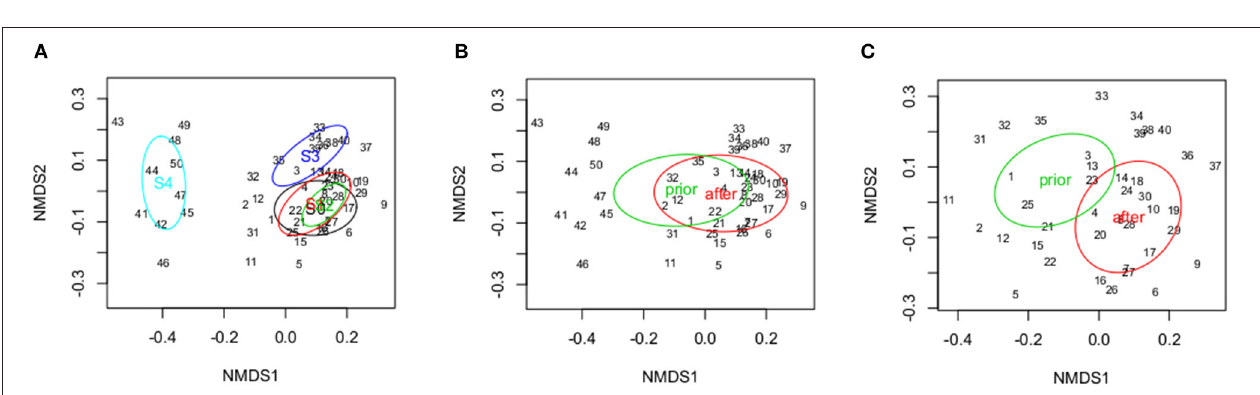
FIGURE 6 | Number of sensitive taxa in spring and autumn prior to (2012 and 2013, dark colors) and after (2014, 2015, and 2016; light colors) the wastewater treatment plant (WWTP) upgrade. Data are shown as arithmetic means and standard deviations. Data for the sampling sites at the Schussen river are shown in red colors: S 0 upstream of the WWTP and upstream of the stormwater overflow basin (SOB) Mariatal, S 1 upstream of the WWTP and downstream of the SOB, S 2 directly downstream of the WWTP, S 3 15km downstream of the WWTP; data for the sampling site S 4 at the Argen river are shown in green colors.